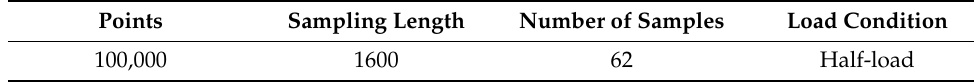
Table 5. Actual data with insufficient dataset.